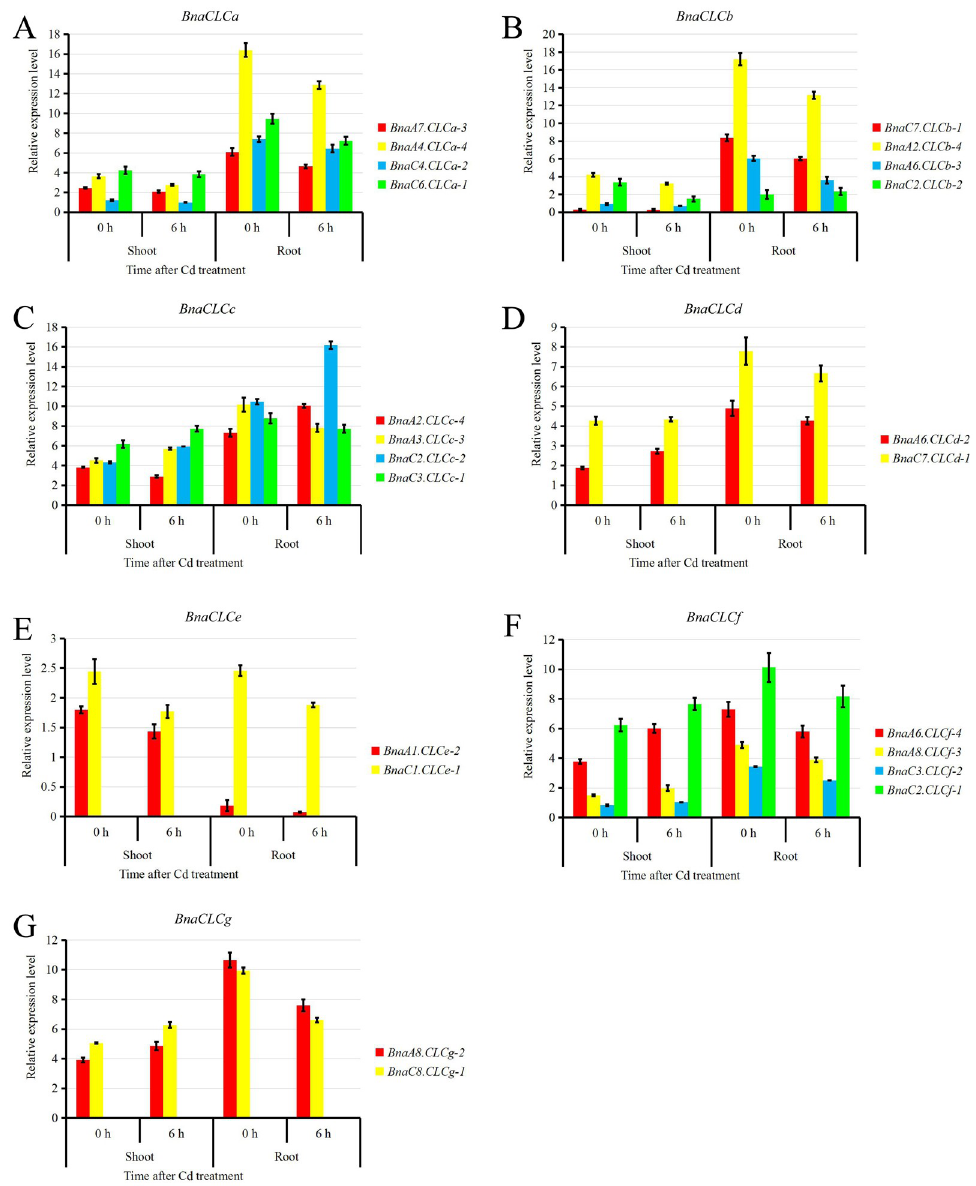
Fig 9. Relative expression of the BnaCLC family members under cadmium (Cd) toxicity. Relative expression levels of BnaCLCa (A), BnaCLCb (B), BnaCLCc (C), BnaCLCd (D), BnaCLCe (E), BnaCLCf (F), and BnaCLCg (G), as revealed by the qRT-PCR assays. For the Cd toxicity treatment, the rapeseed seedlings were first grown under a Cd-free solution for 10 d, and then transferred to 10 μ M CdCl 2 for 6 h. Bars indicate the standard deviation (SD) of three biological